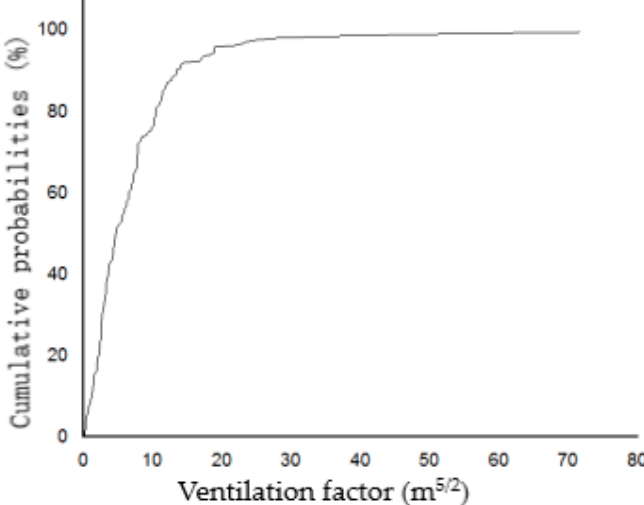
Figure 6. CDF of ventilation factor for high-rise residential buildings.